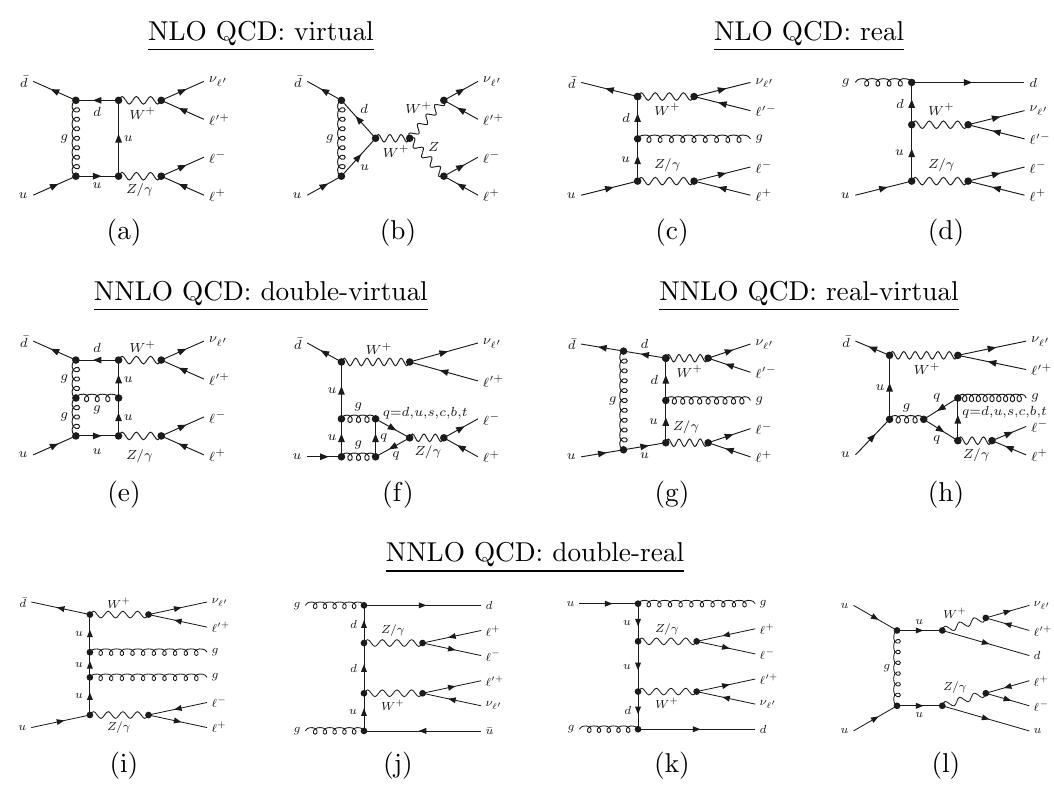
Figure 3 . Sample higher-order QCD diagrams for ‘ + ‘ (cid:0) ‘ 0 (cid:23) ‘ 0 ( WZ ) production: NLO QCD di- agrams of virtual (a{b) and real (c{d) type, and NNLO QCD diagrams of double-virtual (e{f), real{virtual (g{h) and double-real (i{l)